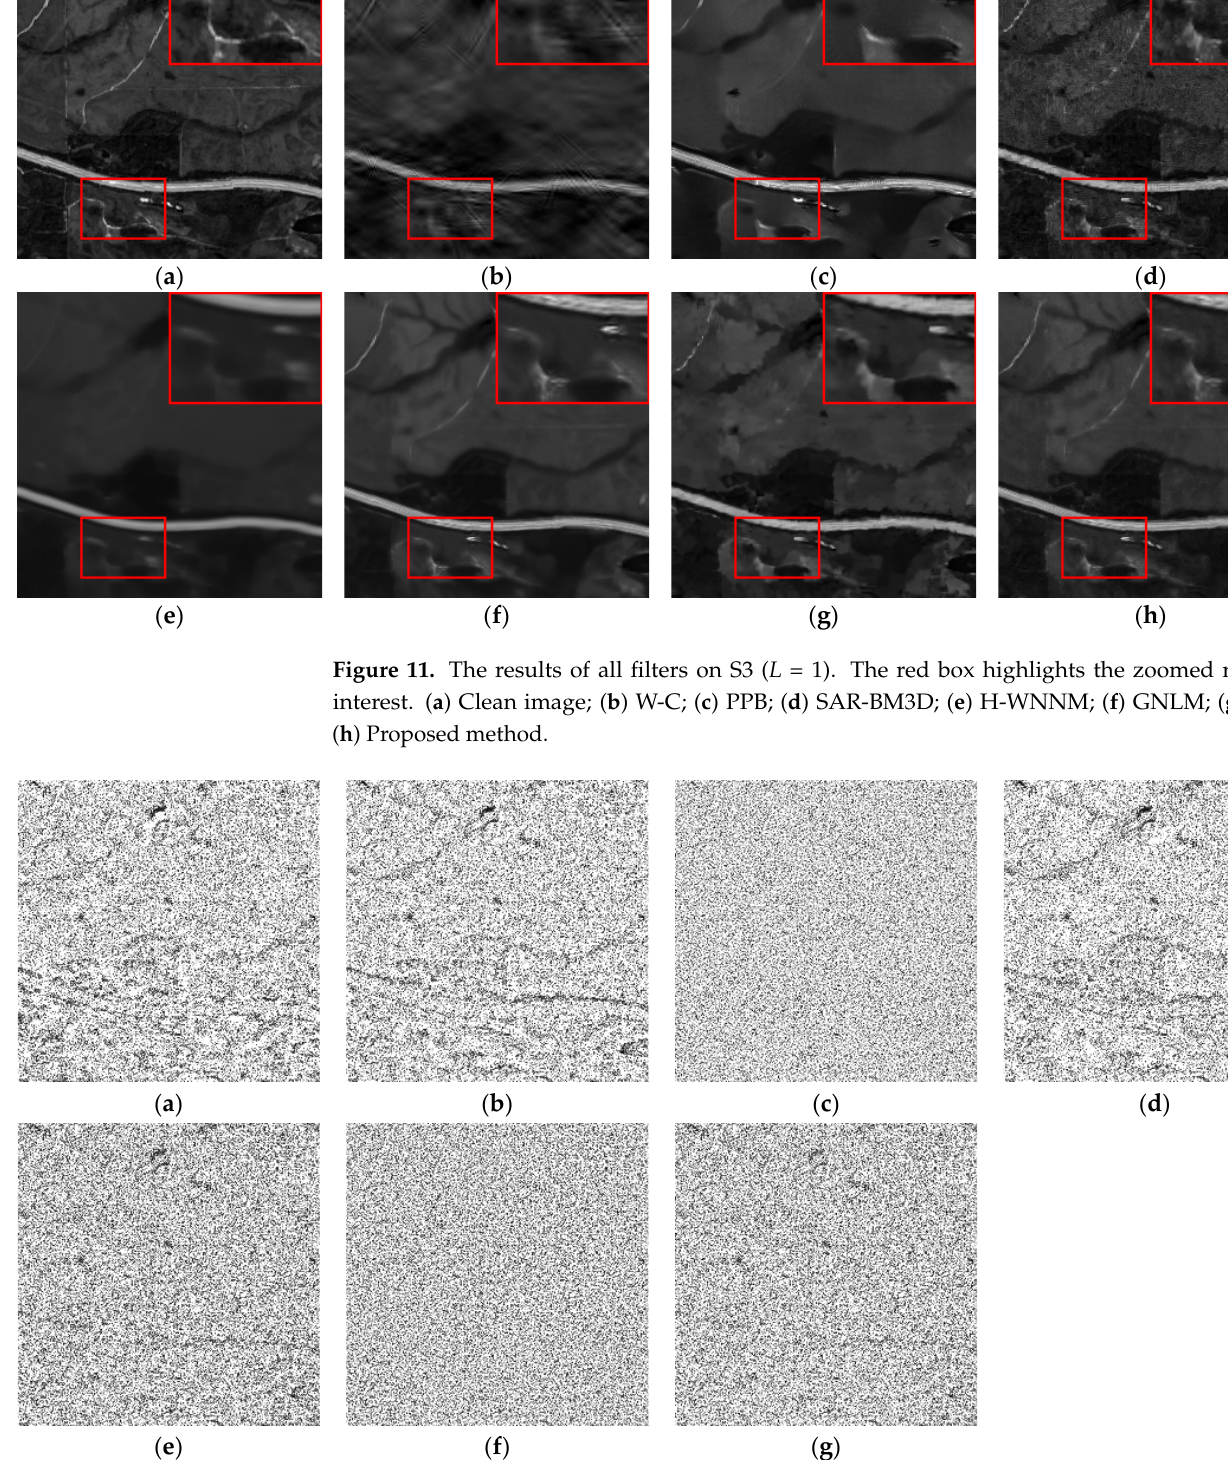
Figure 12. The corresponding ratio images for S3. ( a ) W-C; ( b ) PPB; ( c ) SAR-BM3D; ( d ) H-WNNM; ( e ) GNLM; ( f ) FANS; ( g ) Proposed method.